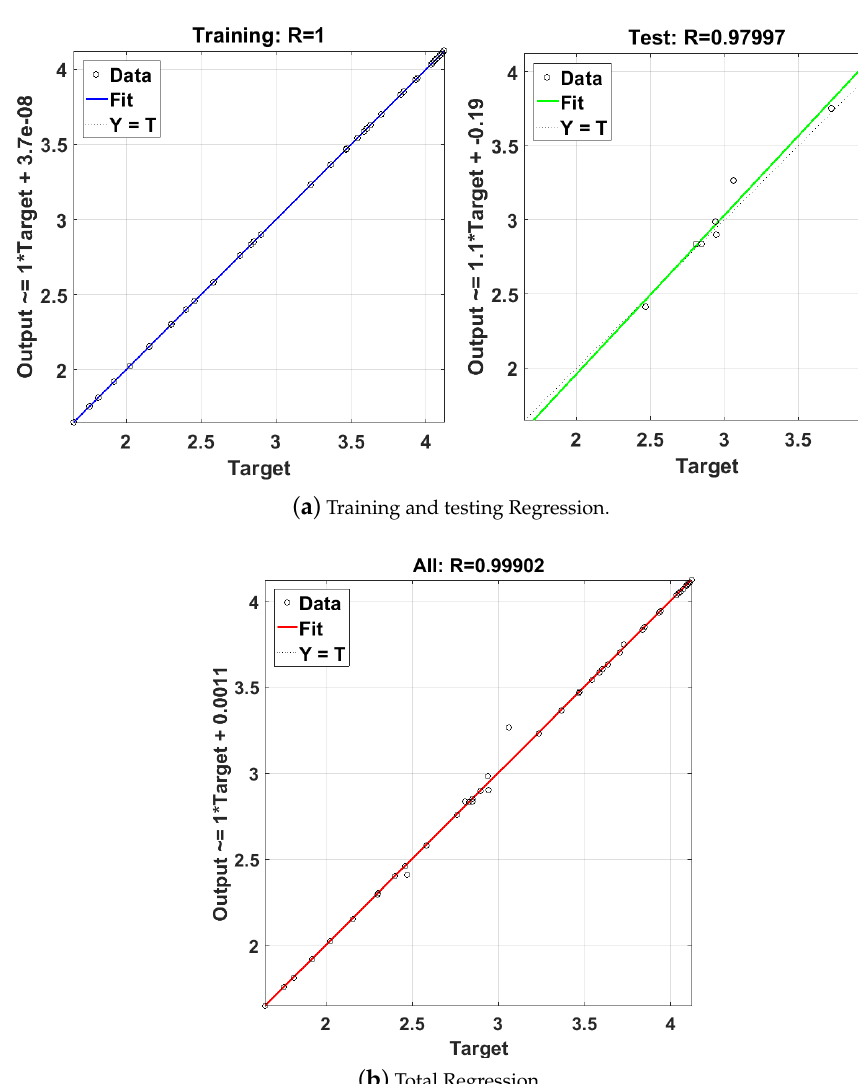
Figure 13. Regression diagram NARX.